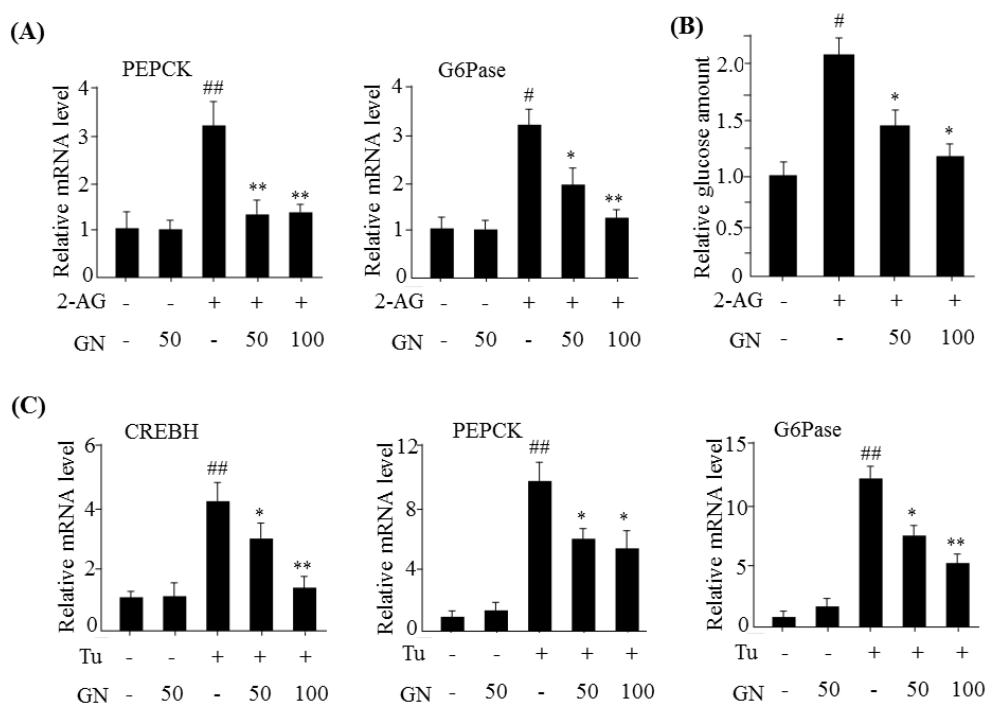
Figure 5. GN inhibited 2-AG-induced gluconeogenesis in HepG2 cells. ( A ) HepG2 cells were incubated with 2-AG in the absence or presence of GN (50 or 100 µM) for 12 h. qPCR analysis of PEPCK and G6Pase ; ( B ) Measurement of glucose production; ( C ) HepG2 cells were incubated with tunicamycin (Tu) in the absence or presence of GN (50 or 100 µM) for 12 h. qPCR analysis of CREBH , PEPCK , and G6Pase . Values are expressed as mean ± SEM ( n = 3 independent experiments). # p < 0.05, ## p < 0.01 vs. untreated control. * p < 0.05, ** p < 0.01 vs. 2-AG or Tu-treated control.